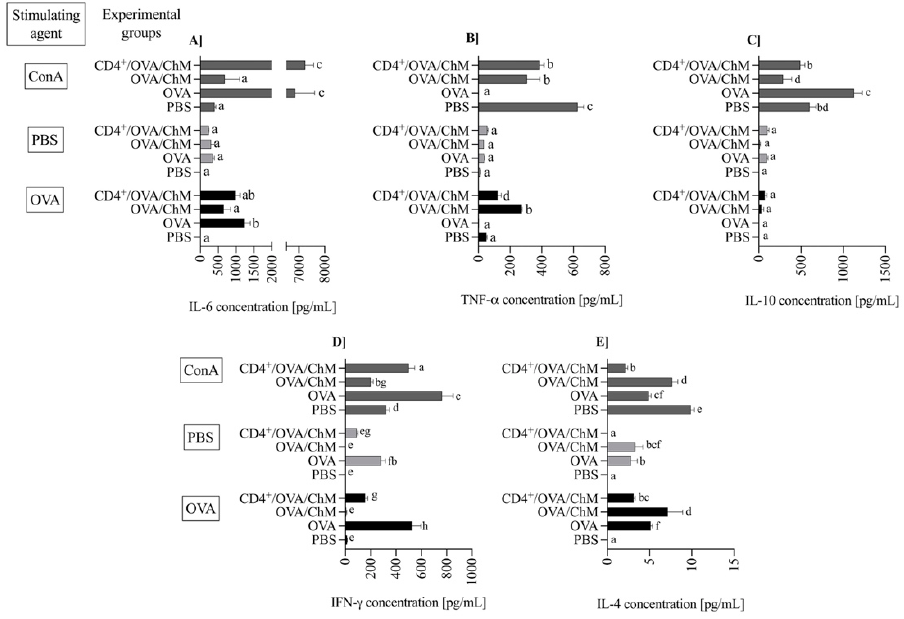
Figure 4. The concentration of cytokines: IL-6 ( A ), TNF- α ( B ), IL-10 ( C ), IFN- γ ( D ) and IL-4 ( E ) in splenocyte cultures from PBS, OVA, OVA/ChM, and CD4 + /OVA/ChM groups: unstimulated (PBS; light gray bars), and stimulated with ovalbumin (OVA; black bars) or concanavalin A (ConA; dark gray bars; assay positive control). Two-way ANOVA with a post hoc Tuckey test was used to determine differences between groups and treatments. The bars represent the mean of the group ( n = 3) ± SD. a,b,c,d,e,f,g Mean values with different superscripts are different at p ≤ 0.05.